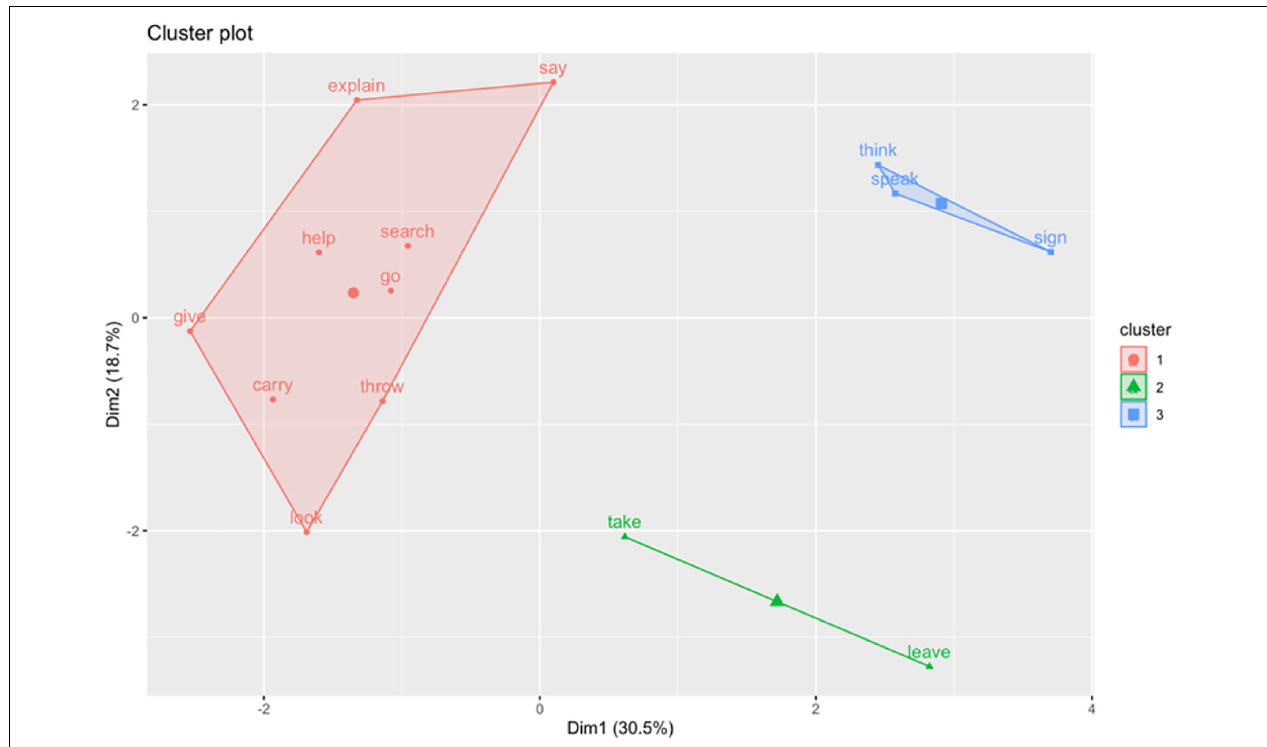
FIGURE 6 | A scatterplot of the three verb meanings